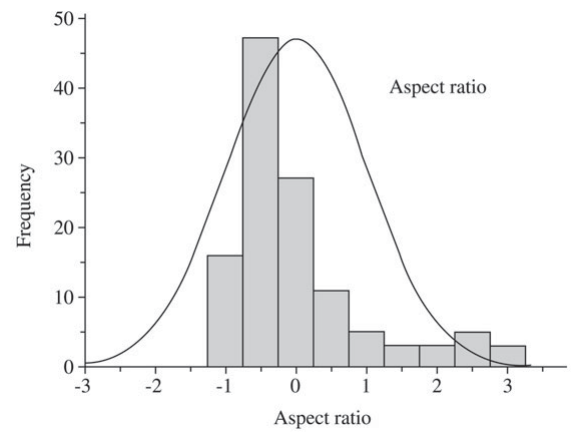
Figure 4. Distribution of frequency adjusted to the standard nor- mal